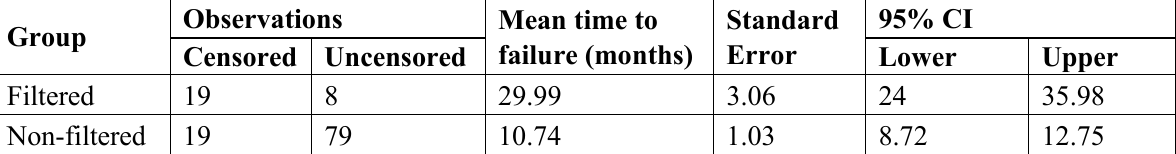
Table 4. Summary of survival function parameters for filtered and non-filtered breeding herds.